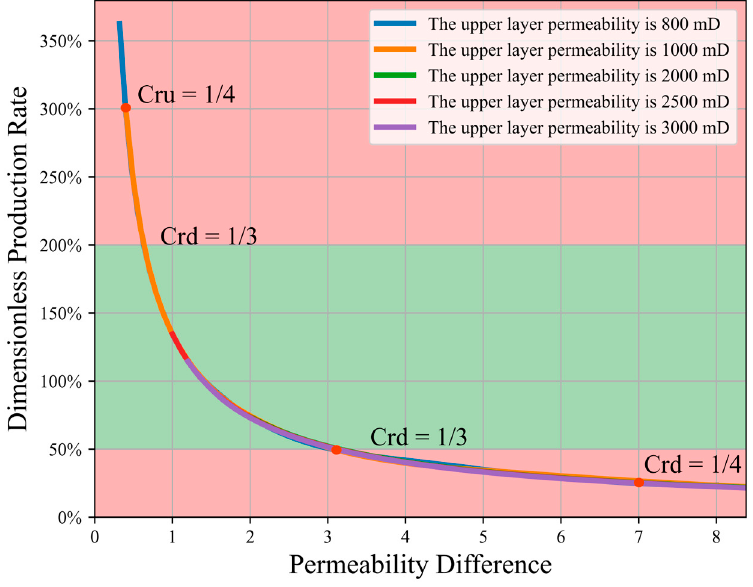
Figure 17. Matching degree curve for permeability difference when change the upper layer perme- ability.